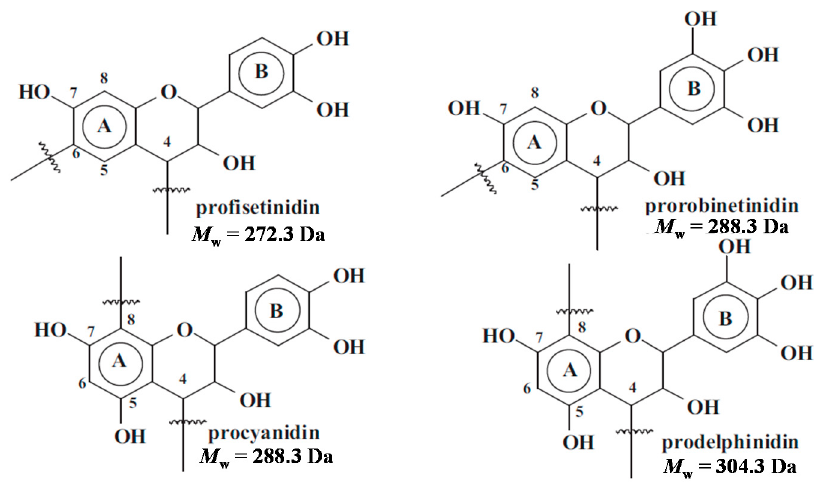
Figure 1. The four main structures in commercial flavonoid tannins.